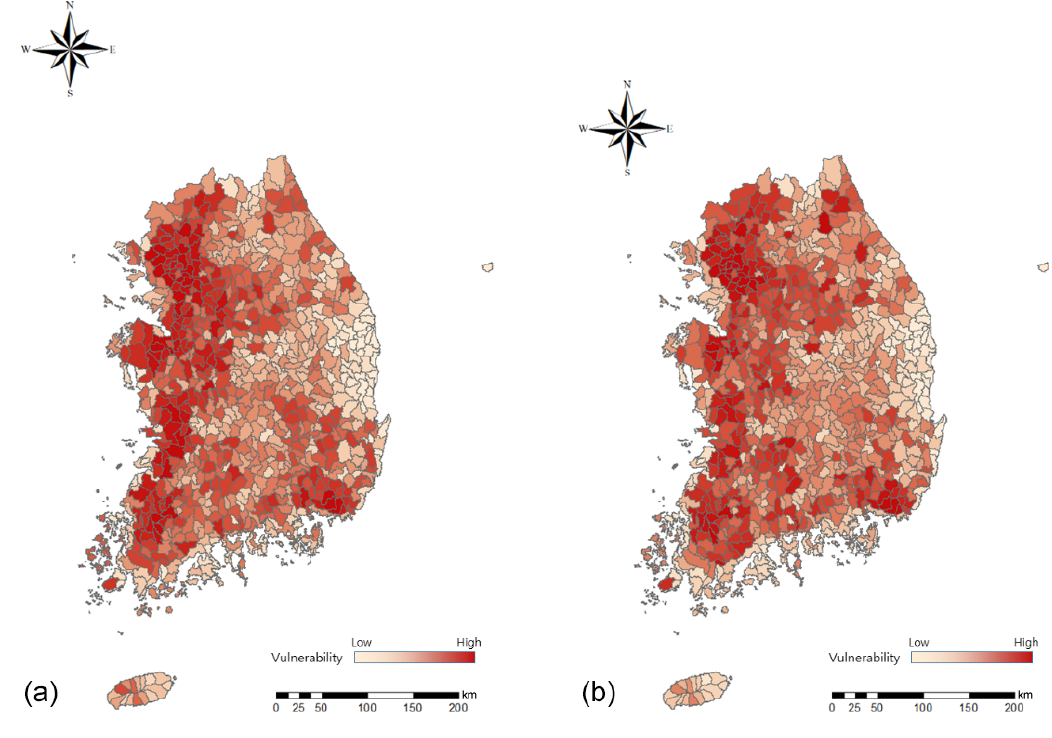
Figure 4. Spatial diffuse pollution vulnerability results for South Korea.